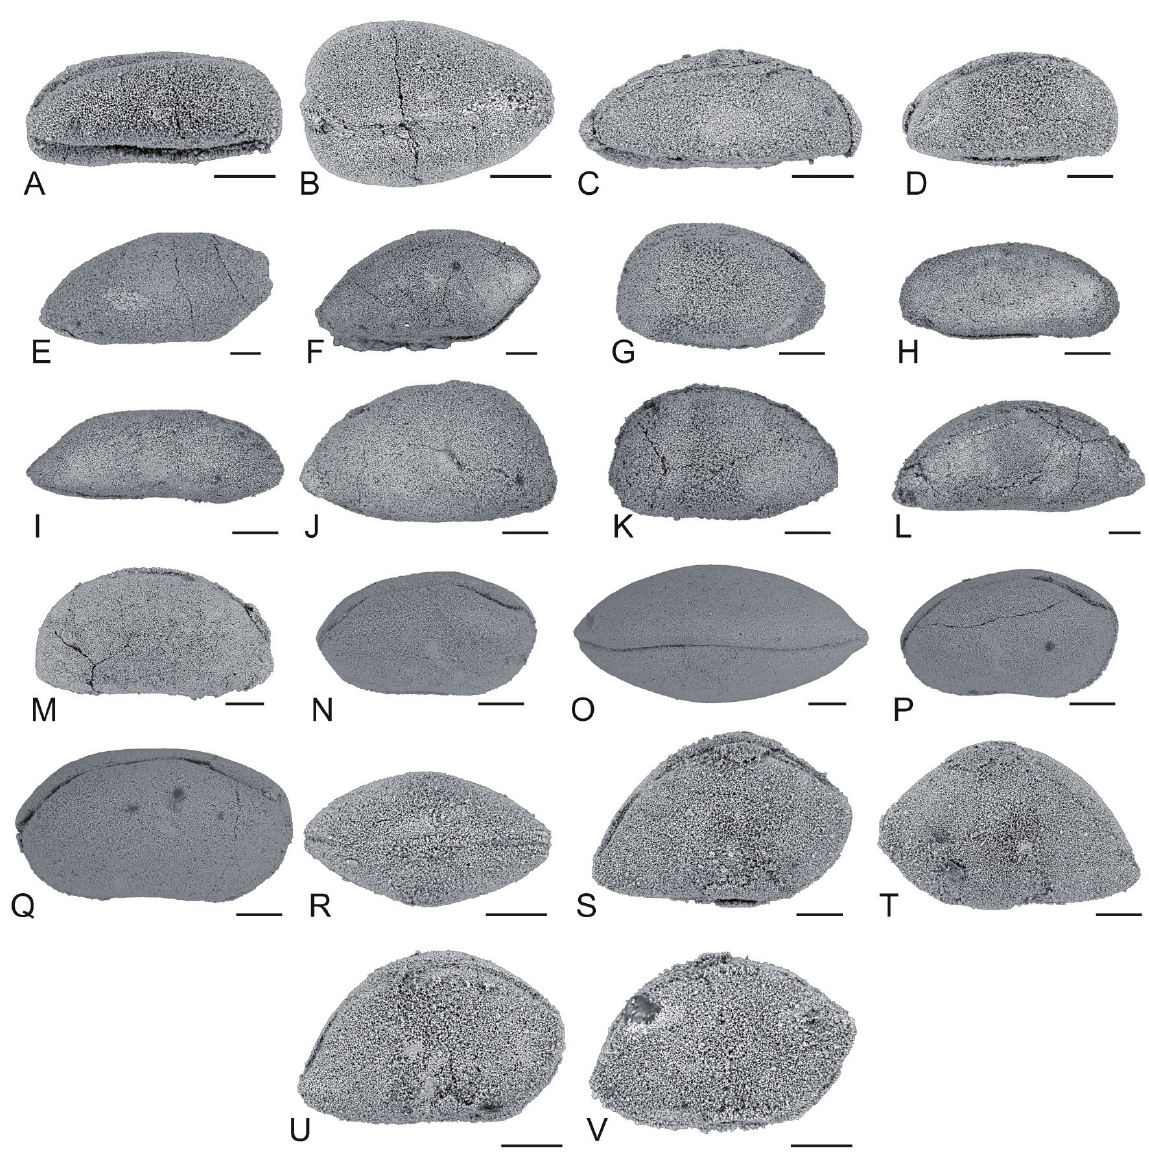
Fig. 3. Ostracods from the Dajiang section, South China. — A–D . Acratia candyae sp. nov. A . Holotype, carapace, right lateral view, P6M2917. B . Carapace, dorsal view, P6M2918. C . Paratype, carapace, right lateral view, P6M2919. D . Carapace, right lateral view, P6M2920. — E–F . Acratia subfusiformis Wang, 1978. E . Carapace, right lateral view, P6M2921. F . Carapace, right lateral view, P6M2922. — G . Acratia ? sp. 1, carapace, right lateral view, P6M2923. — H . Acratia ? sp. 2, carapace, right lateral view, P6M2924. — I . Acratia ? sp. 3, carapace, right lateral view, P6M2925. — J–K . Acratia sp. 4. J . Carapace, left lateral view, P6M2926. K . Carapace, right lateral view, P6M2927. — L . Acratia sp. 5, carapace, right lateral view, P6M2928. — M . Acratiidae indet., carapace, right lateral view, P6M2929. — N–Q . Bairdia adelineae sp. nov. N . Holotype, carapace, right lateral view, P6M2930. O . Carapace, dorsal view, P6M2931. P . paratype, carapace, right lateral view, P6M2932. Q . Carapace, right lateral view, P6M2933. — R–V . Bairdia gaelleae Crasquin, 2010. R . Carapace, dorsal view, P6M2934. S . Carapace, right lateral view, P6M2935. T . Carapace, left lateral view, P6M2936. U . Carapace, right lateral view, P6M2937. V . Carapace, right lateral view, P6M2938. – Scale = 100